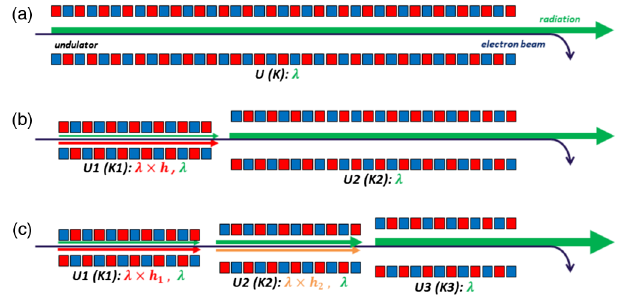
FIG. 1. Conceptual scheme of a SASE FEL (a), a harmonic lasing self-seeded FEL (b) and a harmonic lasing cascade (c). Green arrows correspond to the wavelength of interest λ , amplified through the whole undulator. Red and yellow arrows correspond to the fundamental wavelengths of the corresponding parts of the undulator, tuned to the subharmonic of λ